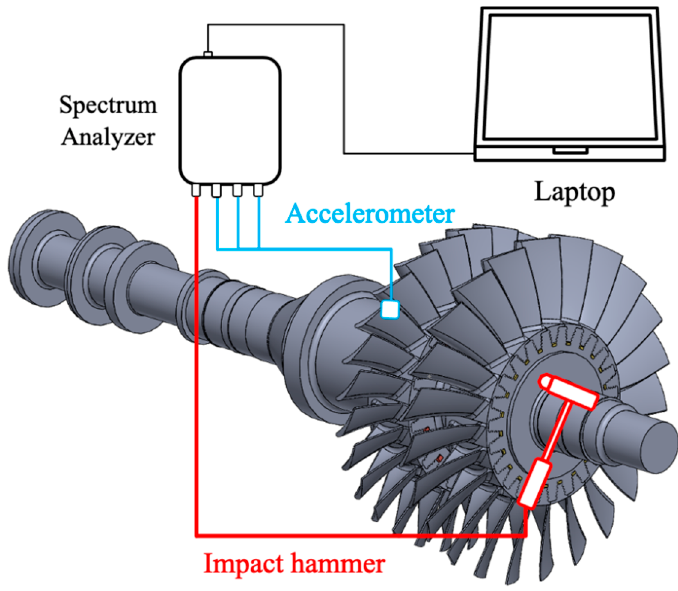
Figure 8. Schematic diagram of X direction and the clock position of twelve o’clock meaning directly ahead of the excitation applied in modal testing.